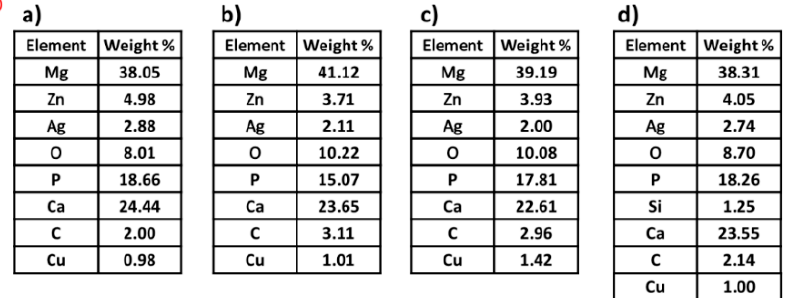
Figure 15. Extracted values from specific area of EDAX analysis of immersed ( a ) alloy and composites ( b ) C1, ( c ) C2 and ( d ) C3 after 30 days.